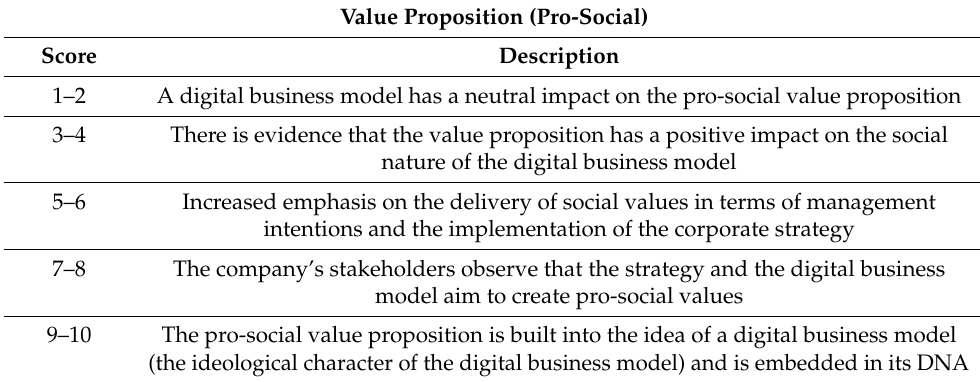
Table 5. Scale used to evaluate a particular company in terms of the criteria (own